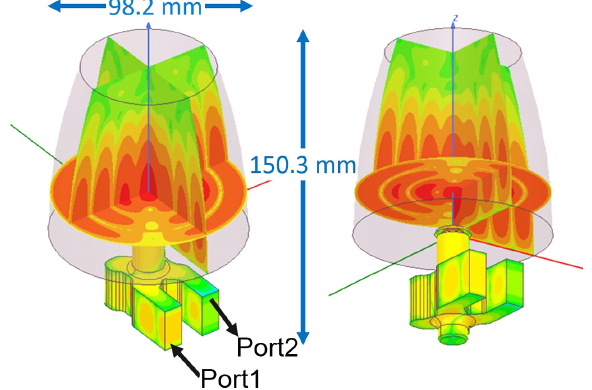
FIG. 9. Electrical field distribution of the correction cavity with the E-rotator. The electrical field is in logarithmic scale.